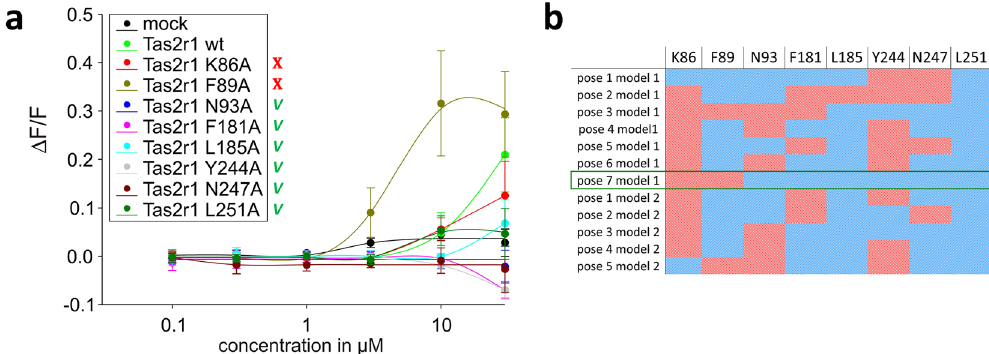
Figure 2. ( a ) Dose-response relations for quinine in cells expressing point-mutated and native ggTas2r1 constructs. The y-axis shows the relative fluorescence changes ( Δ F/F), and the x axis the ligand concentration in μ M. Green checks indicate residues involved in the binding, red crosses residues that are not involved in the binding, based on experimental data. ( b ) Involvement of residues K86, F89, N93, F181, L185, Y244, N247, and L251 in binding modes of quinine in the representative poses obtained with PELE simulations: the cell is colored in blue if the residue is found to interact with the ligand and in red if there is no interaction. The predicted agonist-bound conformation, pose 7 model 1, is marked by a green frame.